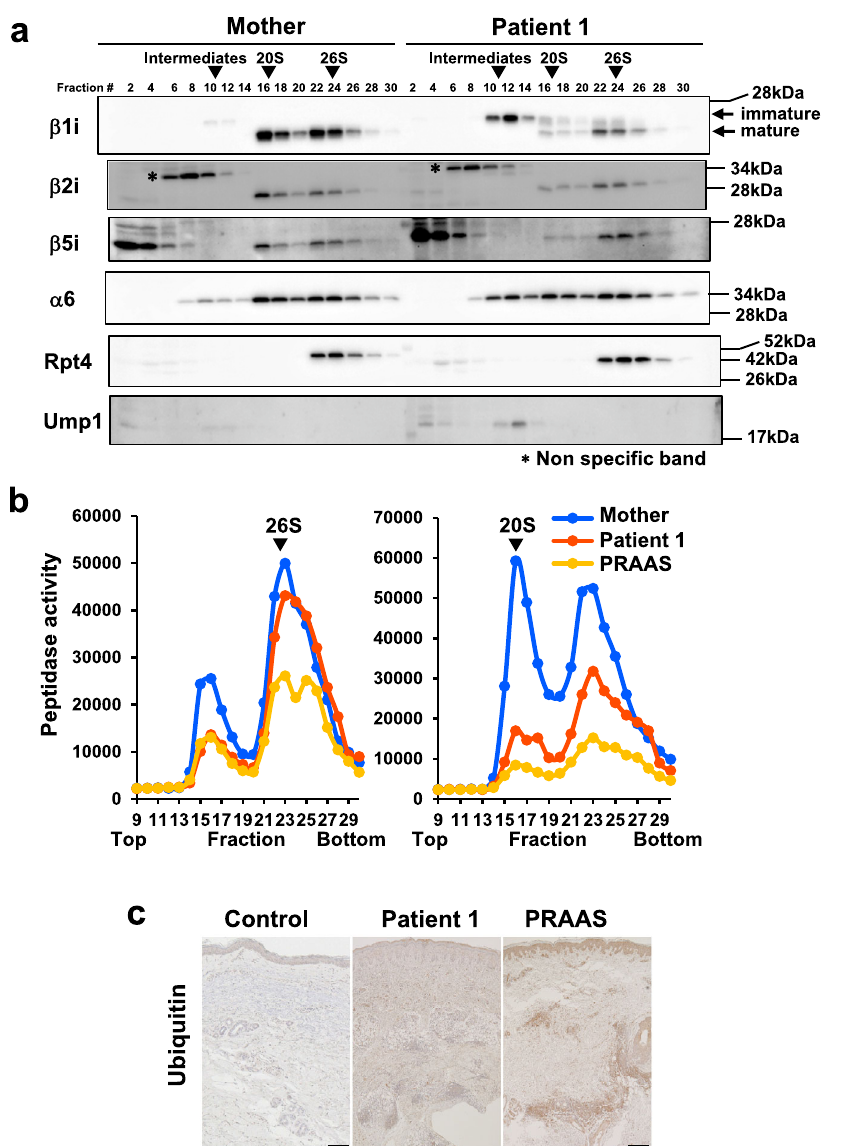
Fig. 3 Proteasome disorder of the patient with the PSMB9 G156D variant. a , b The proteasome analysis of immortalized B cells from patient 1 and his mother. The immortalized B cell extracts were prepared and fractionated by glycerol gradient centrifugation. Data were representative from three independent experiments. a Immunoblot analysis of each fraction using Abs against the indicated proteins. b Chymotrypsin-like activity of each fraction, which was measured by using Suc-LLVY-AMC as a substrate in the absence (left) or presence (right) of 0.0025% SDS. c The skin biopsy samples of a healthy control, patient 1, and a PRAAS patient stained with anti-ubiquitin Ab. Scale bars,100 μ